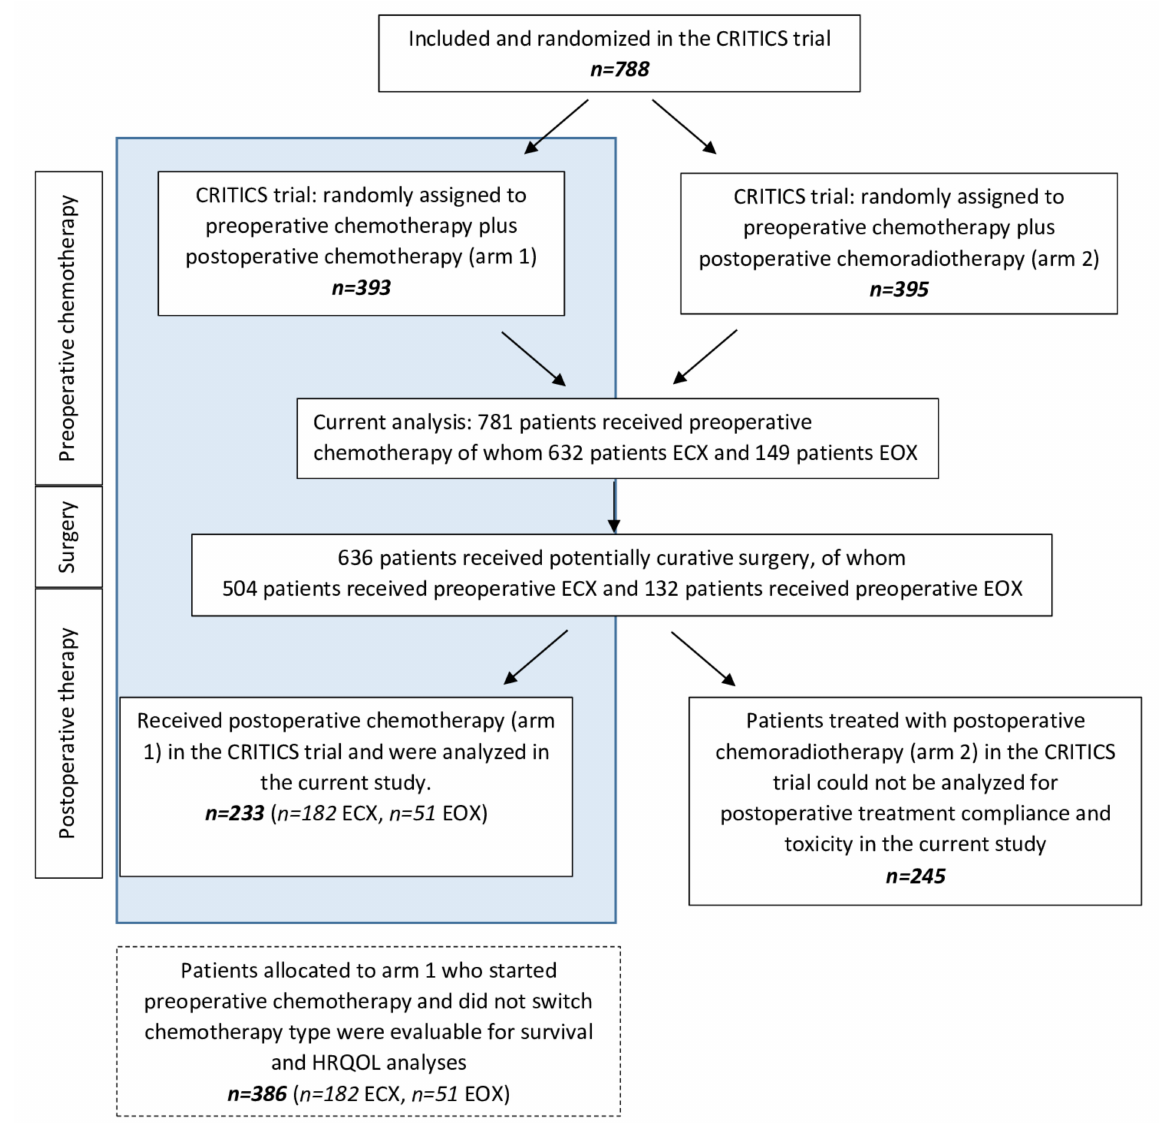
Figure 1. Flowchart of the